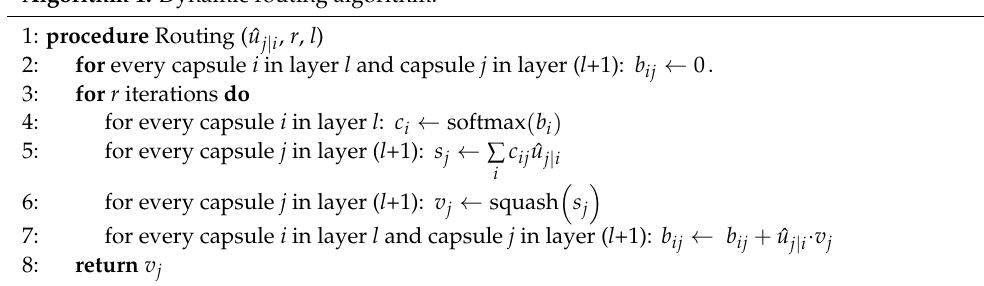
Algorithm 1: Dynamic routing